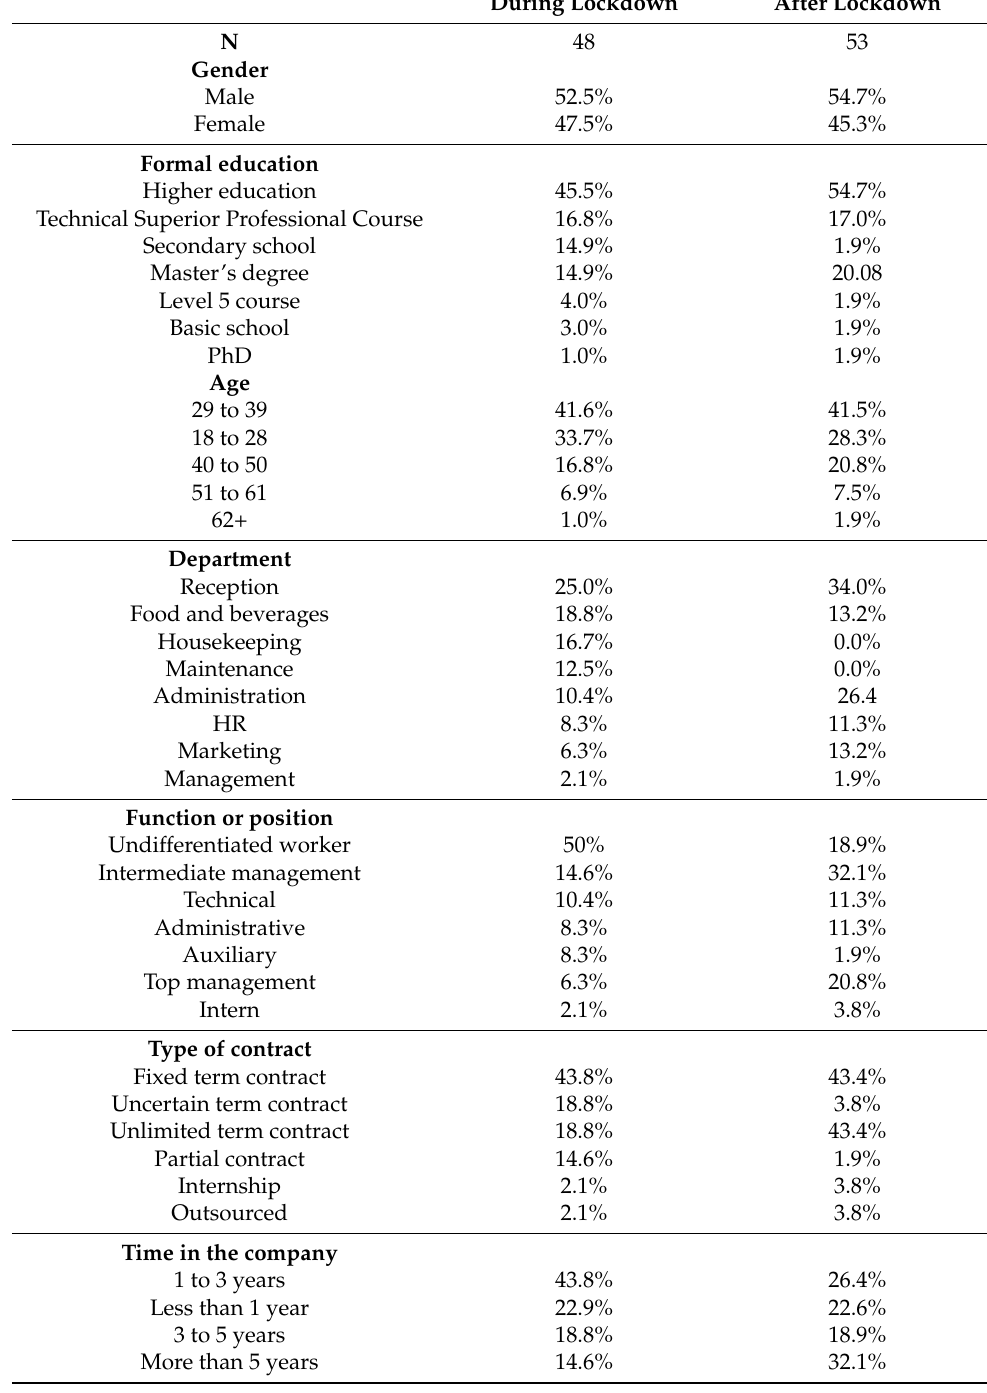
Table 1. Sample comparison—during and post